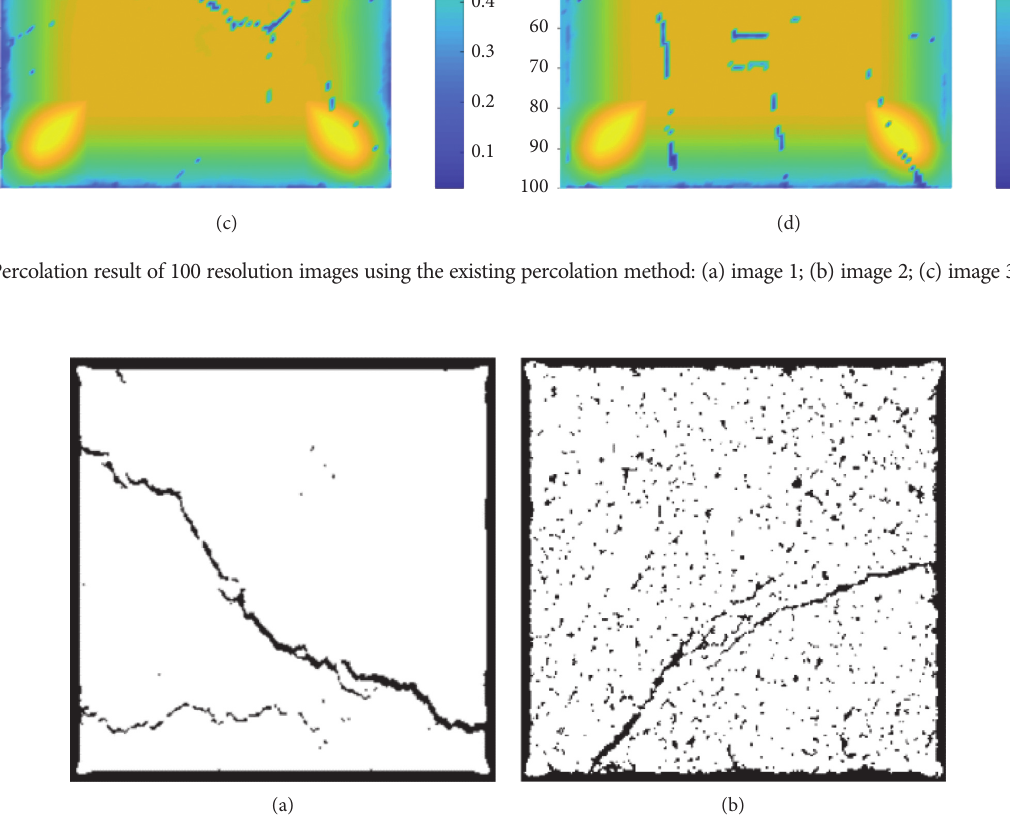
Figure 20: Percolation results without any image expansion techniques: (a) crack 1; (b) crack 2.